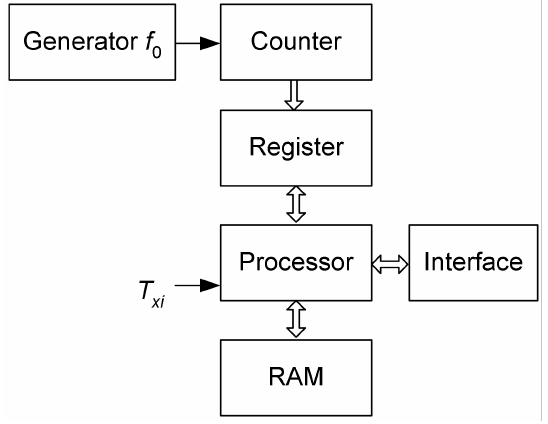
Figure 1. Continuous frequency measurement using a single counter and state capturing